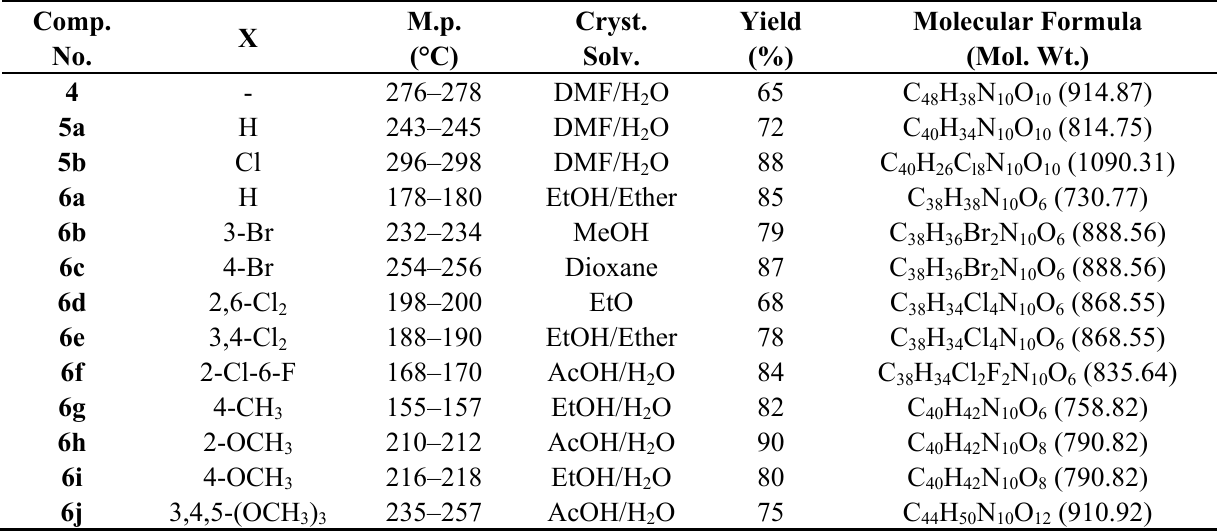
Table 1. Melting points, crystallization solvents, yields, molecular formulae and molecular weights of compounds 4 , 5a , b and 6a – j . Comp.